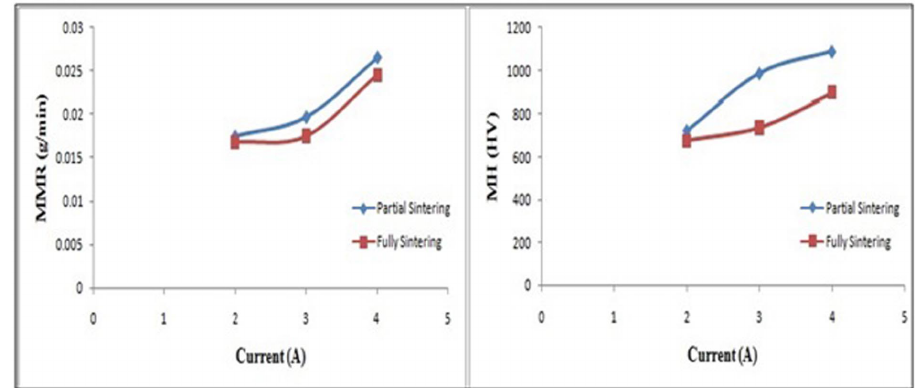
Figure 5: Effect of discharge current on MMR and